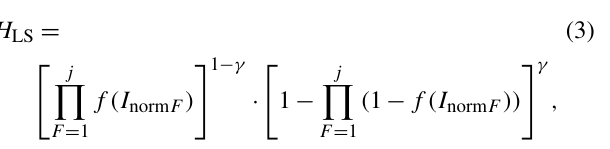
for each pixel such